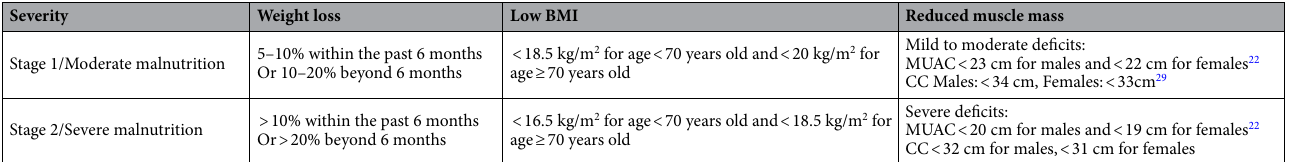
Table 4. Thresholds for severity grading of malnutrition according to GLIM-DCM. Source : Cederholm et al. 9 . MUAC Mid-upper arm circumference, CC Calf